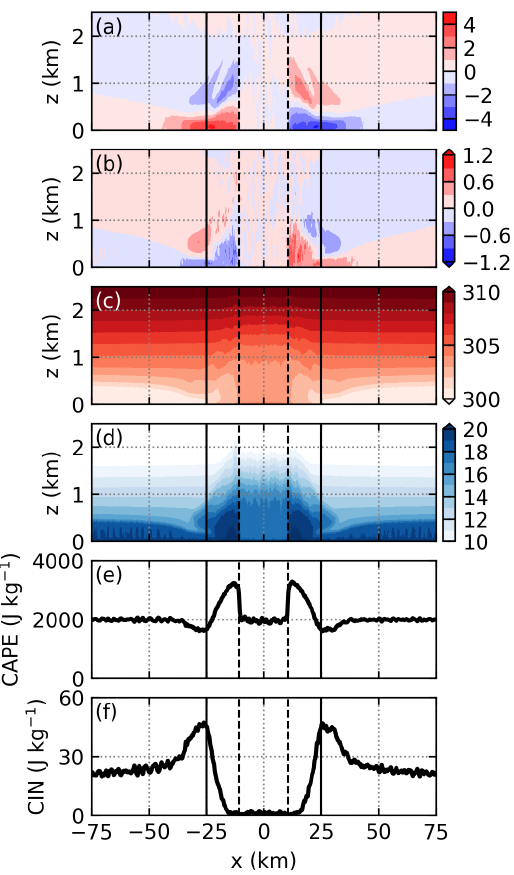
Figure 4. Pseudo albedo in simulation THF700 at (a) t = 5h, (b) t = 6h, (c) t = 7h, and (d) t = 8h. (e) Cloud-top height (km) at t = 8h. Note that only the land part is shown.